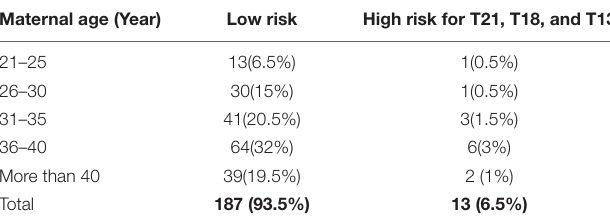
TABLE 3 | Correlation of age with high risk for T21, T18, and